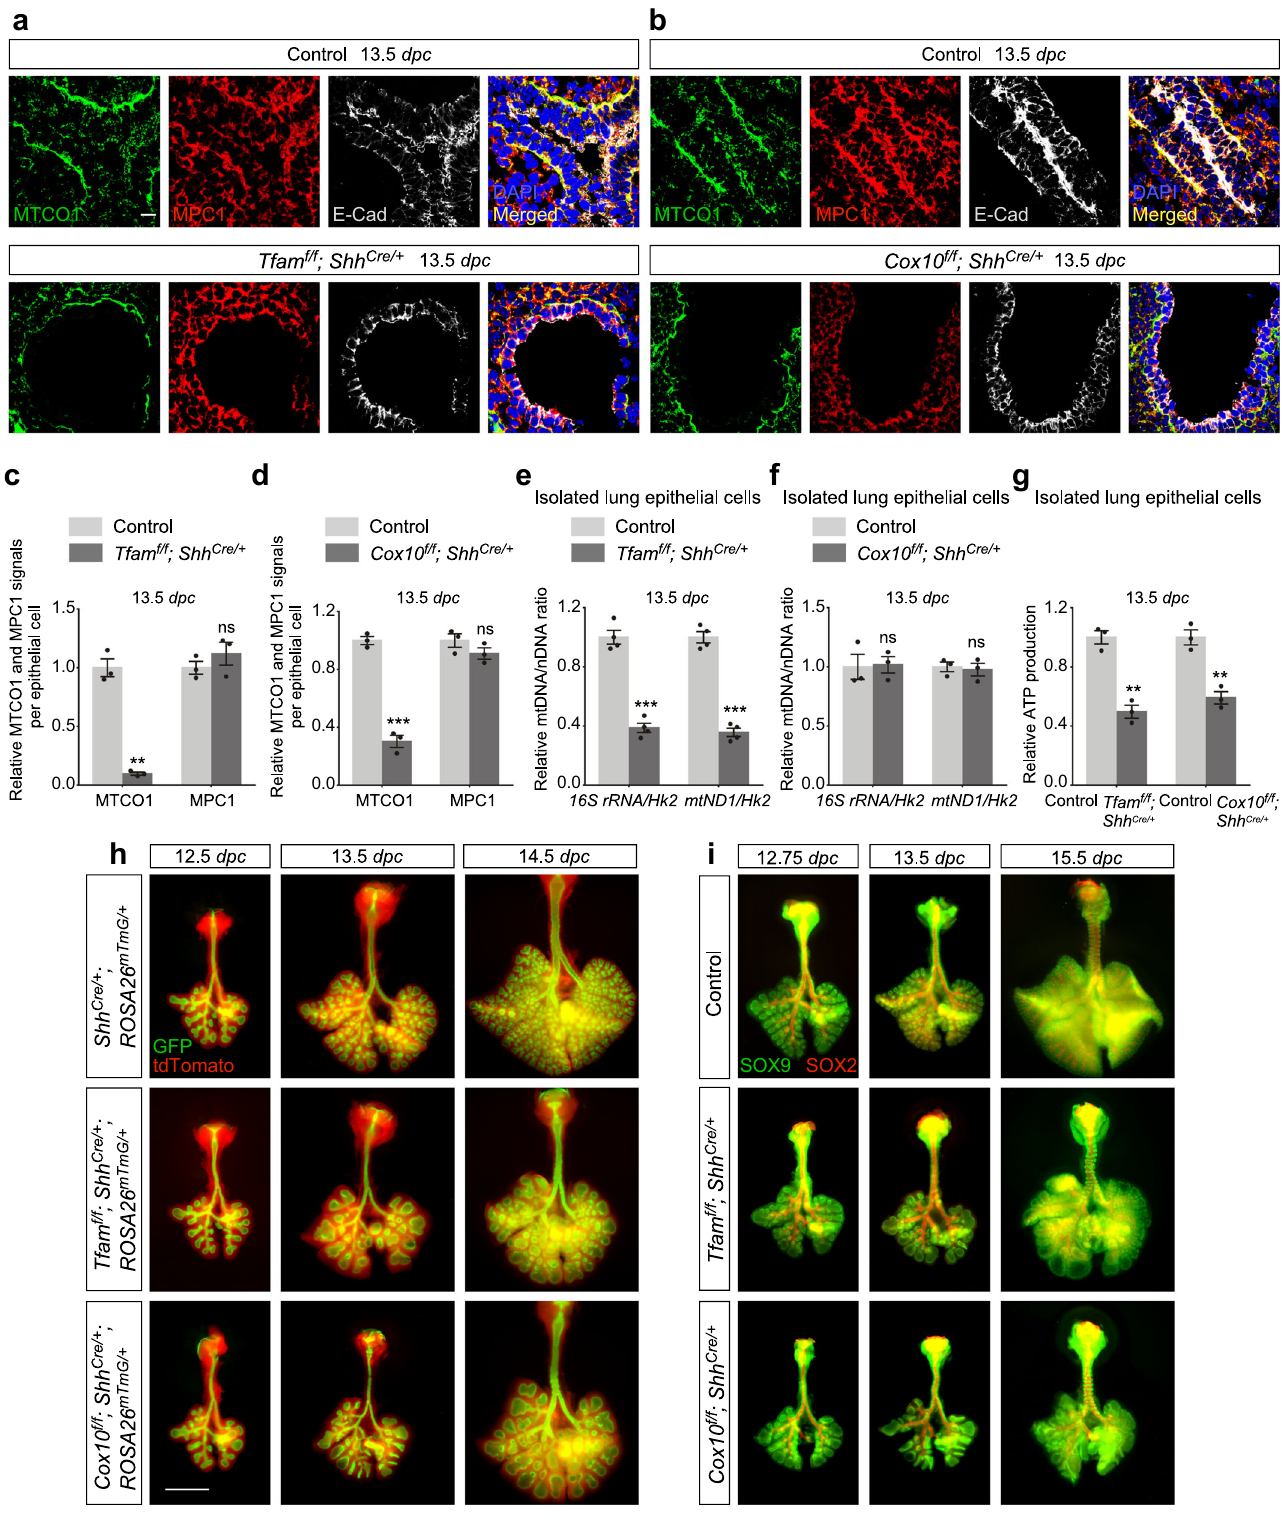
Analysis of mtDNA/nDNA ratio mtDNA/nDNA ratio was evaluated as previously described 31 . Brie fl